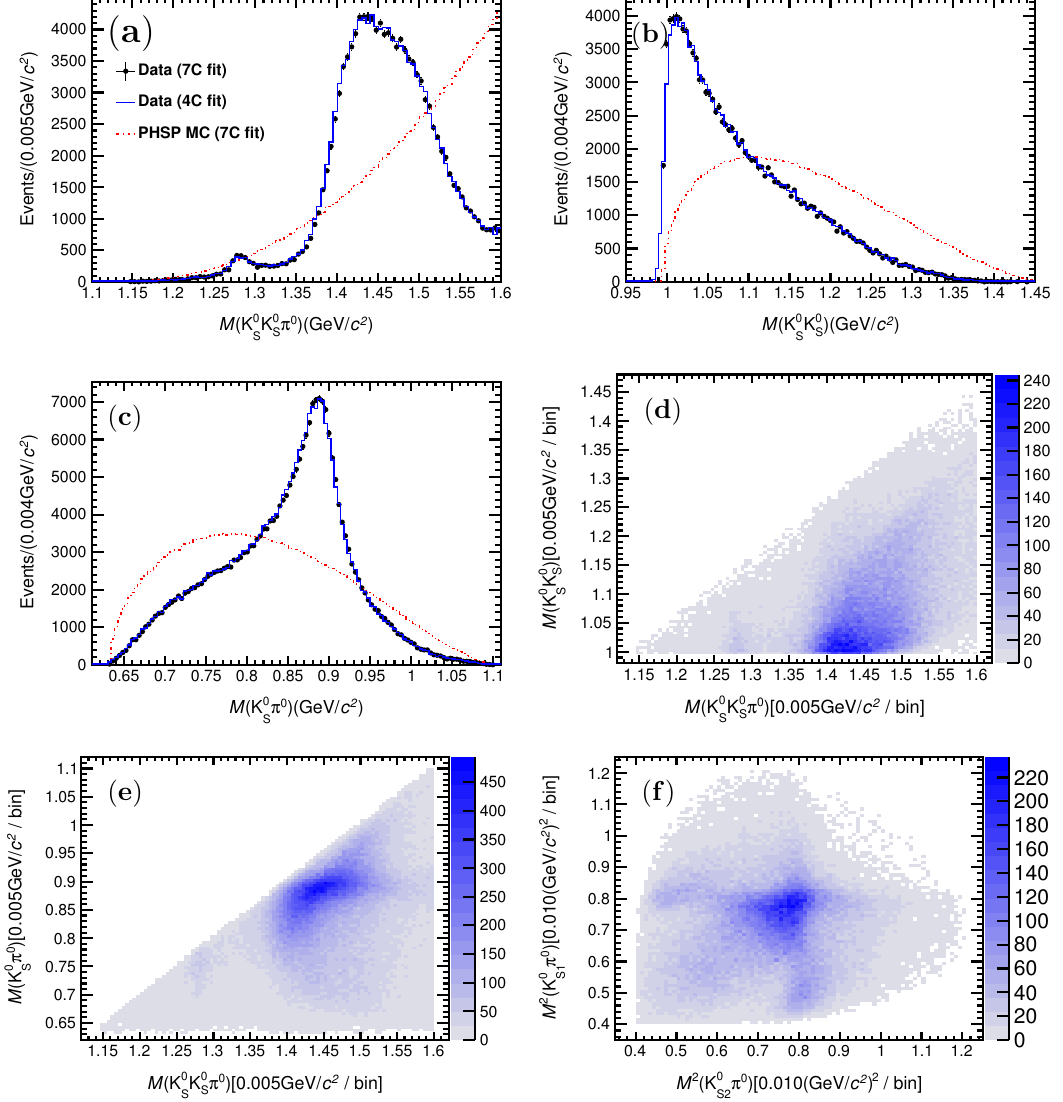
, and (c) K 0 Figure 2 . Invariant mass spectra of (a) K 0 K 0 π 0 , (b) K 0 K 0 π 0 for events with the S S S S S requirement M ( K 0 K 0 π 0 ) < 1 . 6 GeV /c 2 . The corresponding two-dimensional distributions of (d) S S ) versus M ( K 0 M ( K 0 K 0 K 0 π 0 ) and (e) M ( K 0 π 0 ) versus M ( K 0 K 0 π 0 ) . The corresponding Dalitz S S S S S S S plot of (f) M 2 ( K 0 π 0 ) versus M 2 ( K 0 π 0 ) . Dots with error bars are the data with the 7C kinematic S 1 S 2 fit applied. The blue solid line and the red dotted line represent the data with the 4C kinematic fit applied and the signal PHSP MC samples with the 7C kinematic fit applied (normalized by integral),